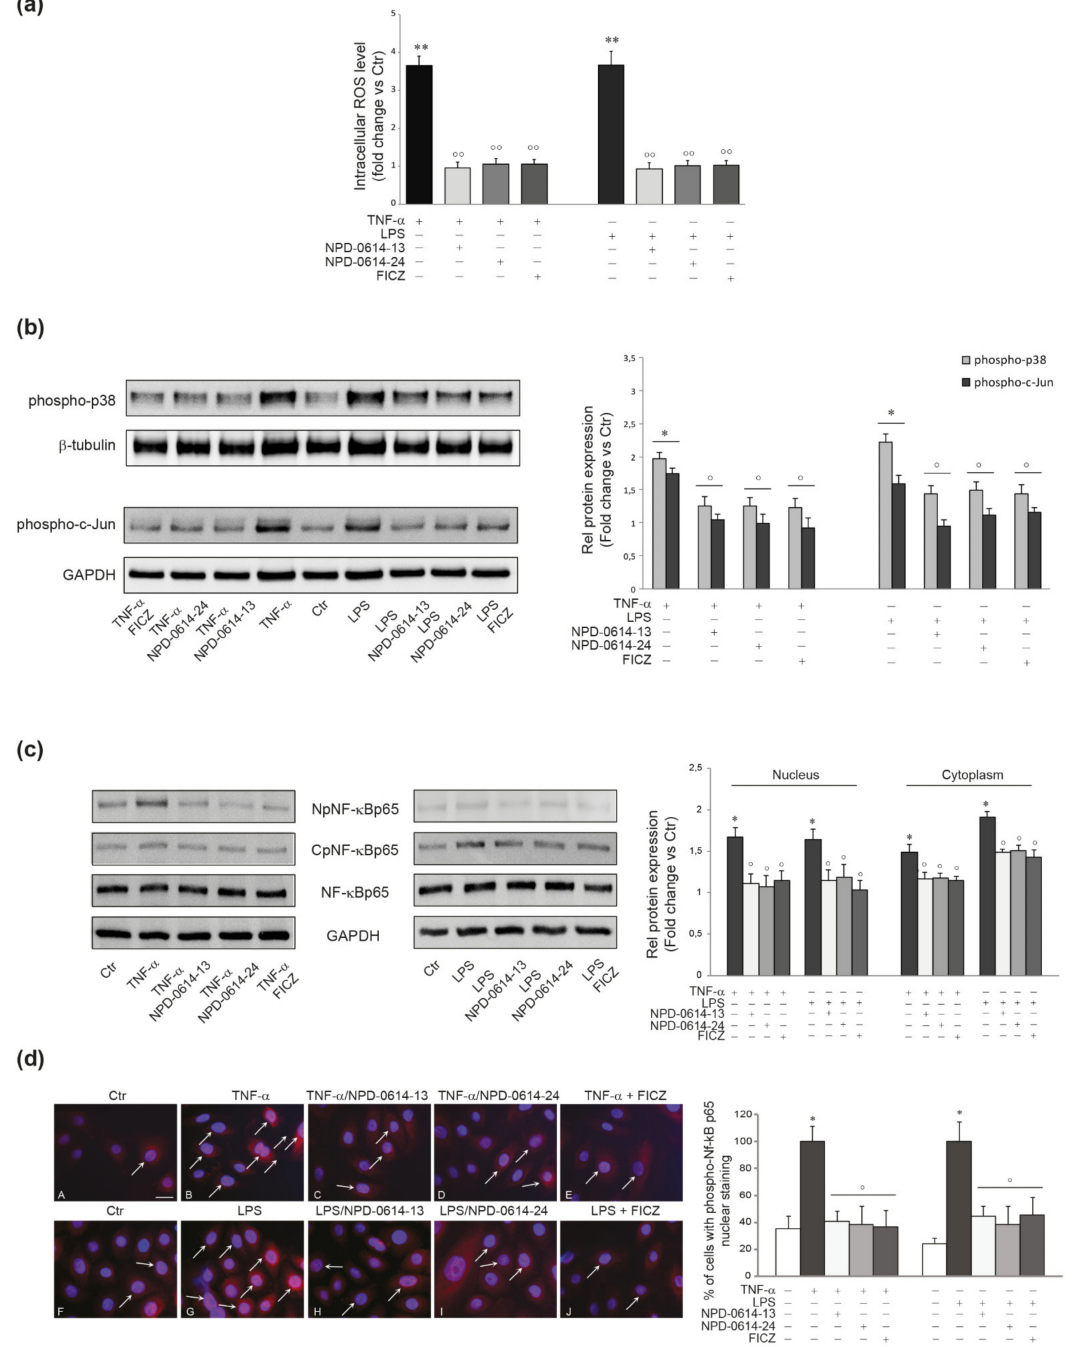
Figure 3. NPD-0614-13 and NPD-0614-24 recovered the altered proliferation induced by TNF- α or LPS in NHKs. ( a ) Western blot analysis and corresponding densitometric analysis of pERK1/2 protein expression in NHKs treated with TNF- α (20 ng/mL) or LPS (10 µ g/mL) in the presence or absence of NPD-0614-13, NPD-0614-24 (25 µ M) and FICZ (100 nM) for 1 h. ( b ) Western blot analysis and corresponding densitometric analysis of p21 protein expression in NHKs treated as above for 6 h. β -tubulin or GAPDH were used as endogenous loading control. Results are expressed as the fold change respect to untreated control cells. Data represent the mean ± SD of three independent experiments (significance vs. untreated control or vs. stimulated cells are marked with * and ◦ , respectively; * p < 0.05 vs. untreated cells; ◦ p < 0.05 vs. TNF- α or LPS stimulated cells). ( c ) Representative immunofluorescence images and fluorescence quantitative analysis of Ki67 expression in NHKs treated as above for 48 h. Nuclei were counterstained with DAPI. Bar: 20 µ m. Results are expressed as the mean percentage of Ki67-positive cells (* p < 0.05 vs. untreated cells; ◦ p < 0.05 vs. TNF- α or LPS stimulated